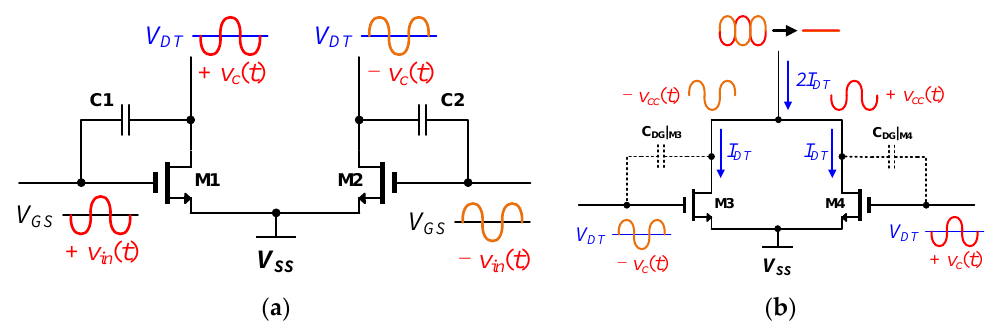
Figure 1. Architecture of the proposed CMOS sub-THz detector.